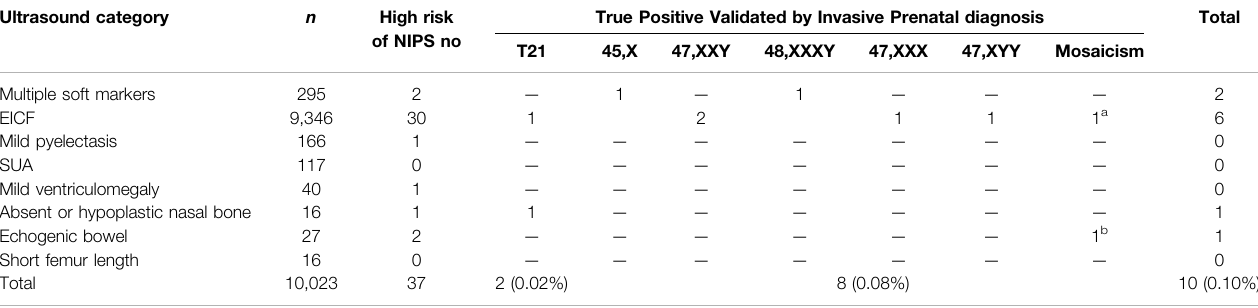
TABLE 2 | Numerical abnormality of chromosomes in the fetus. Ultrasound category n High risk